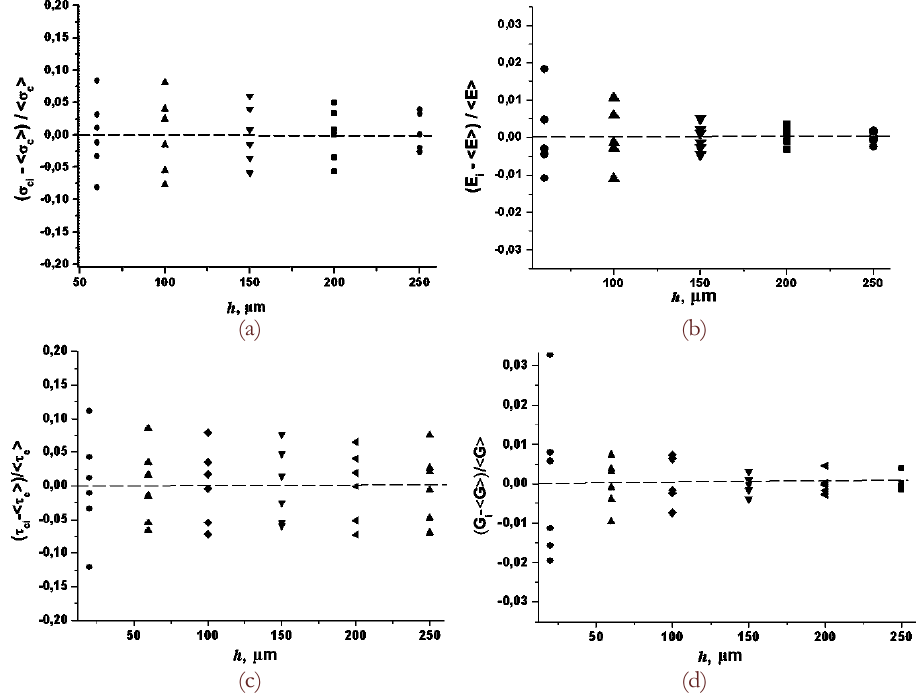
Figure 2: Relative deviation of compression modulus E eff , shear modulus G eff , compression strength σ c and shear strength τ c of